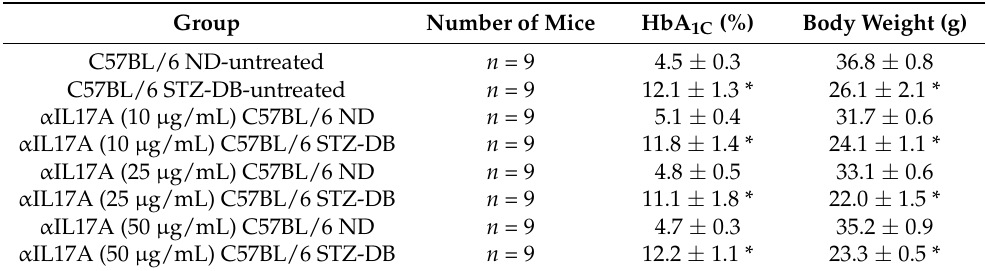
Table 1. Clinical data of STZ-diabetic mice receiving intravitreal injection of anti-IL-17A. Group Number of Mice HbA 1C (%) Body Weight (g)